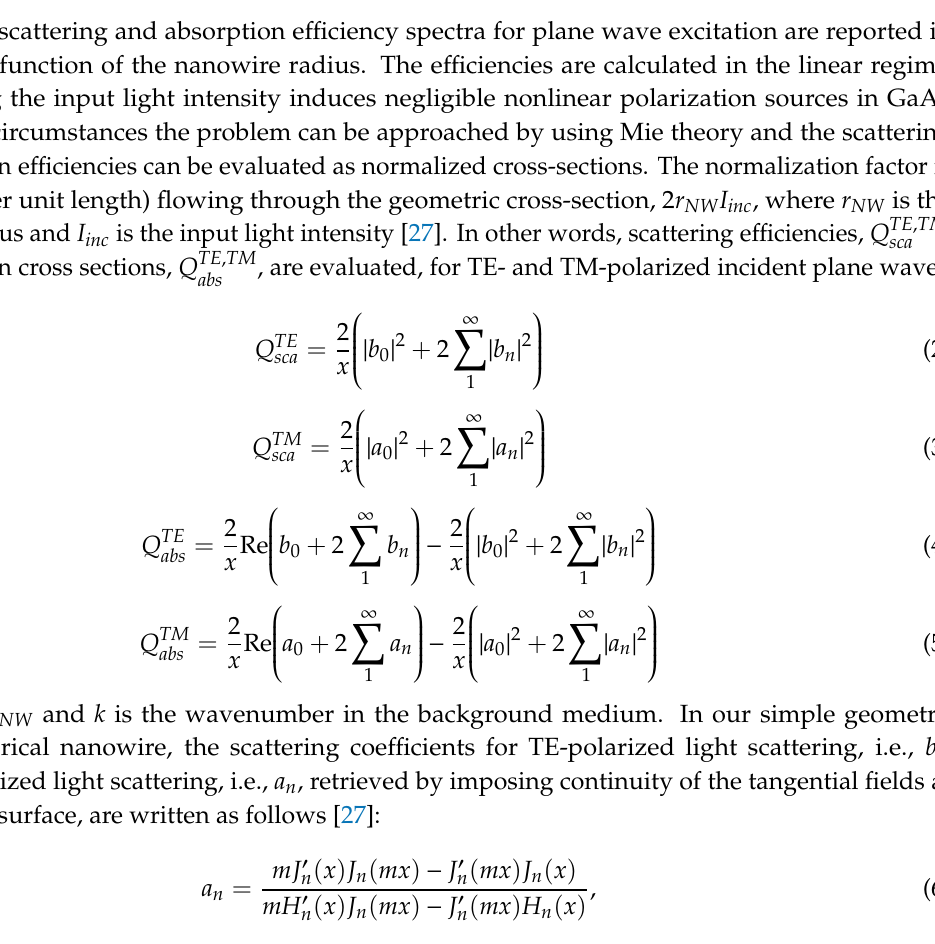
Figure 1. ( a ) Real and imaginary parts of the GaAs relative permittivity, 𝜖 𝐺𝑎𝐴𝑠 , in the wavelength range of interest. ( b ) Real and imaginary parts, and amplitude, of the GaAs second-order nonlinear susceptibility, 𝜒 (2) for second-harmonic (SH) generation. The 𝑥 -axis in ( b ) refers to pump wavelength.